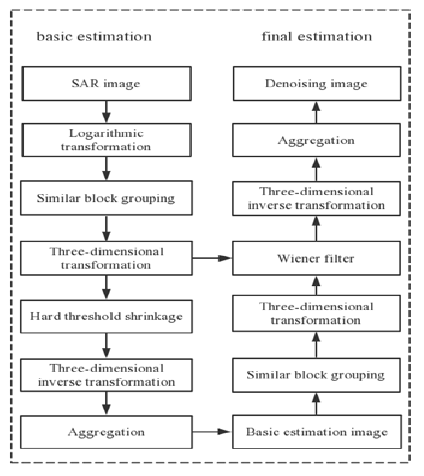
Figure 1. Algorithm flow chart in this paper